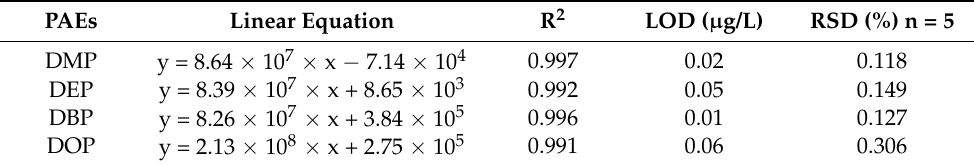
Figure 4. Standard curve of mixed substances. Table 4. Detection limit of PAEs.